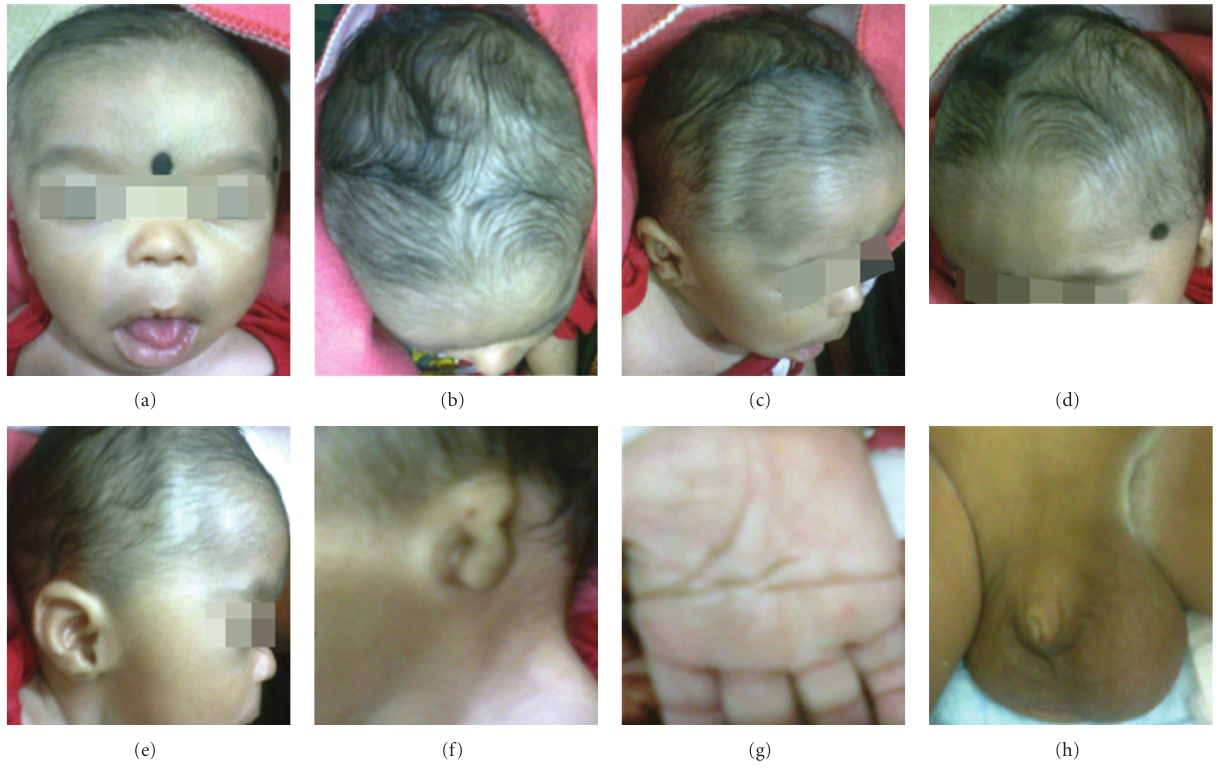
Figure 1: (a)–(h) Phenotype of the child at 62 days age.